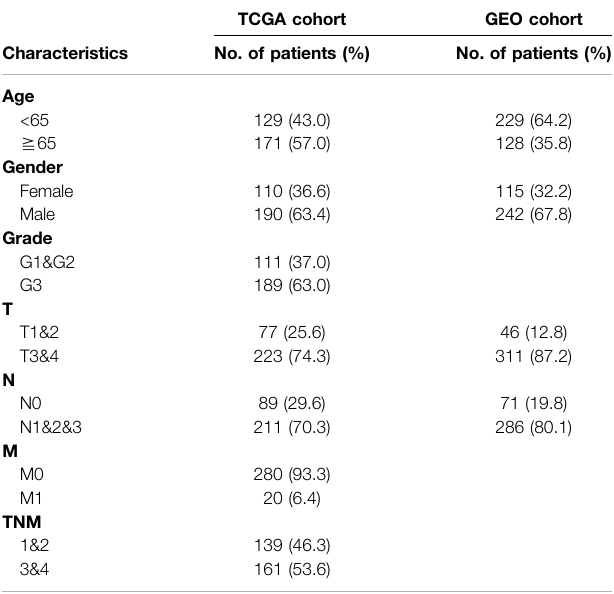
TABLE 1 | Clinical characteristics of patients with gastric cancer in TCGA and GEO database. TCGA cohort GEO